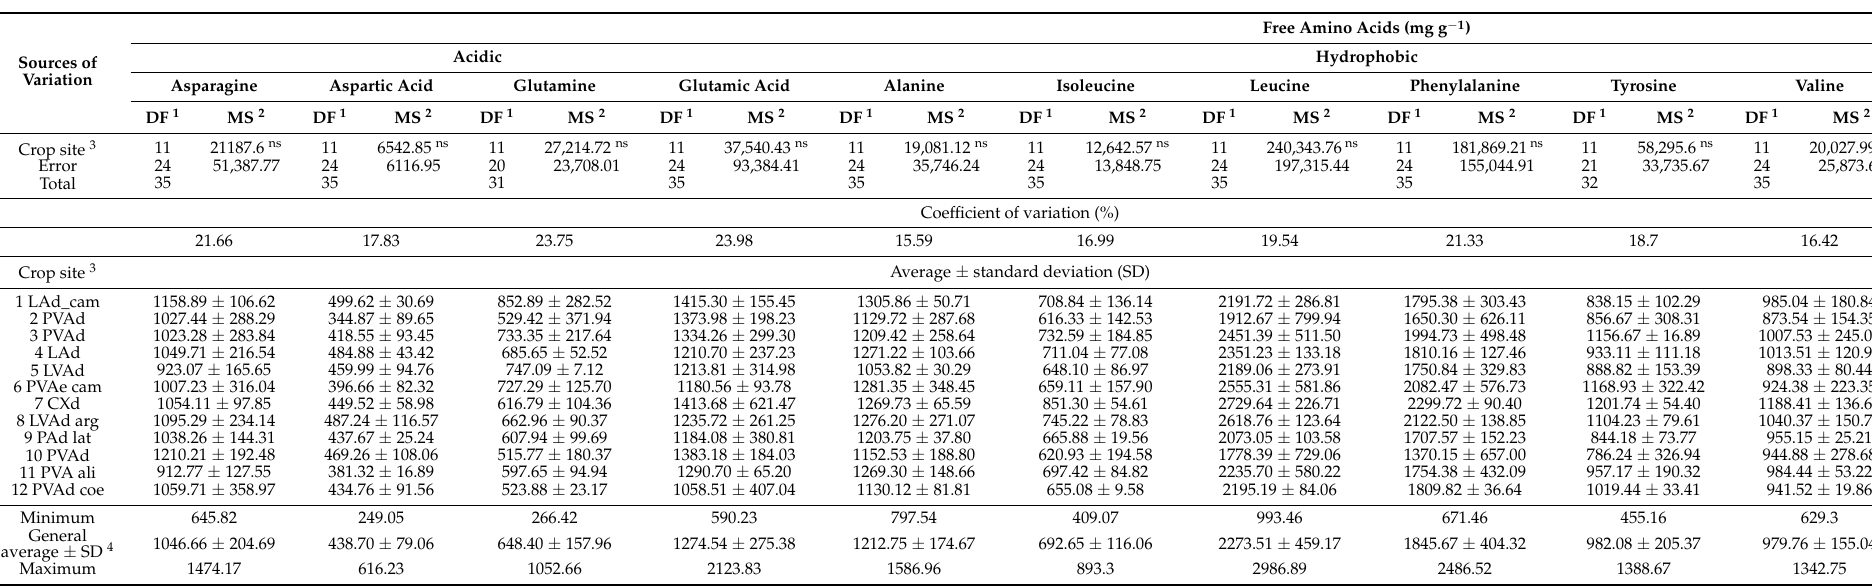
Table 3. Effect of different edaphic crop conditions in the humid zone of southeast Bahia, Brazil on acidic and hydrophobic free amino acids of PH-16 dry cacao beans.